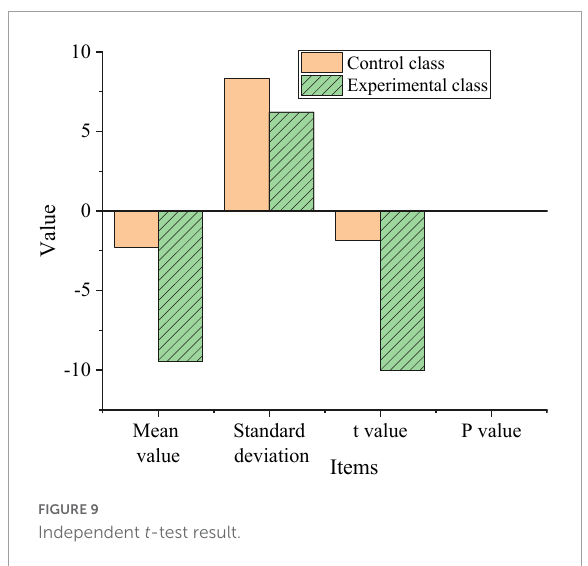
FIGURE9 Independent t -test